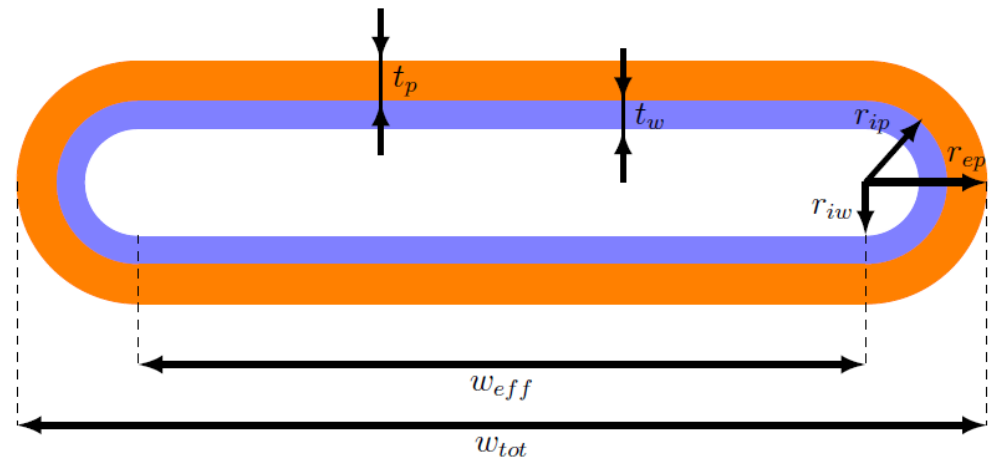
Figure 4. Scheme of the real heat pipe